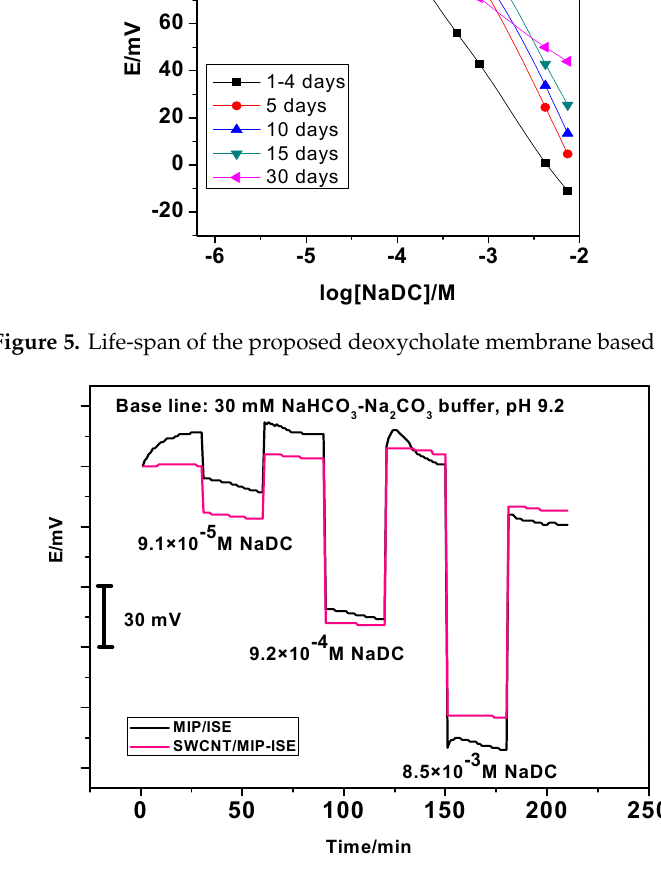
Figure 6. Water-layer tests for NaDC–ISE with and without single-walled carbon nanotubes (SWCNTs) as the solid contact.